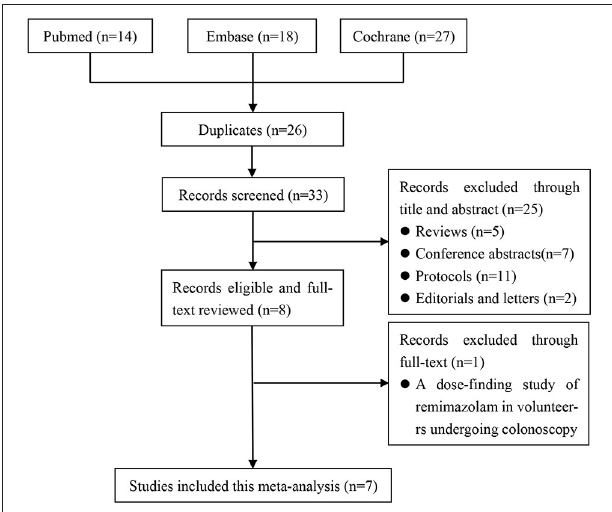
FIGURE 1 | The screening process of the eligible literatures.